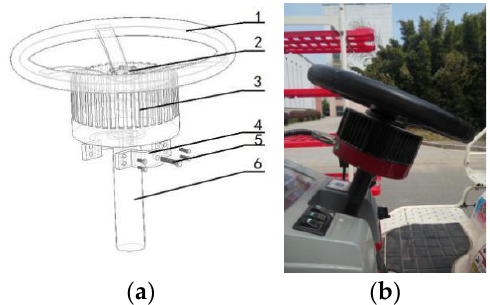
Table 1. Parameters of steering wheel-like motor.